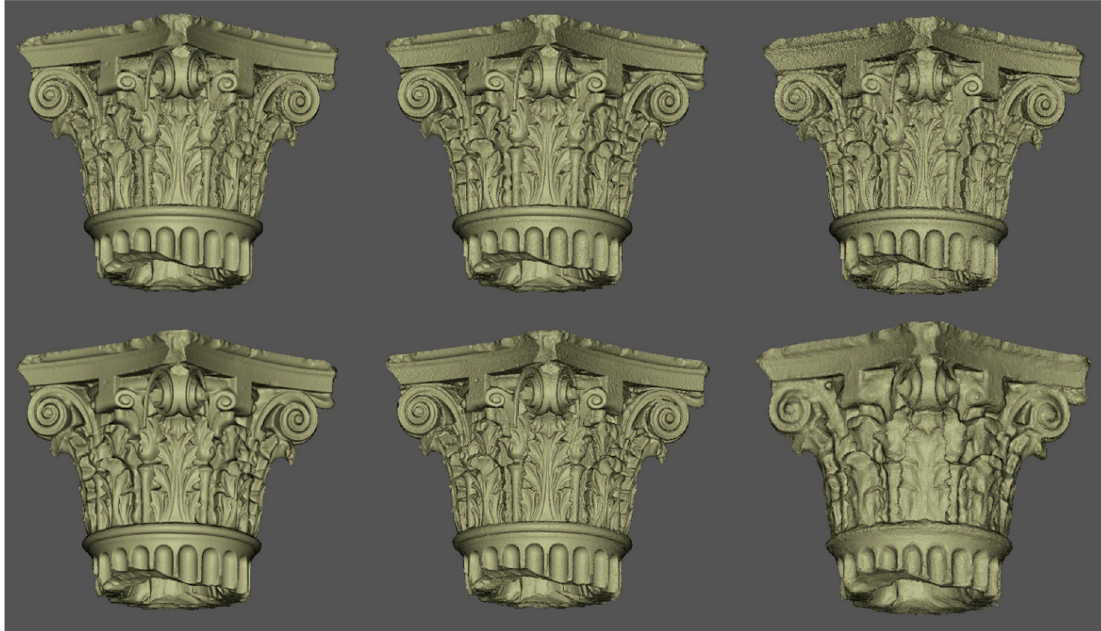
Figure 10. Untextured photogrammetric meshes of the capital replica from dataset 5, (from left to right, and from top to bottom): AMP, FZA, P4D, ARP, VCM, R3D.